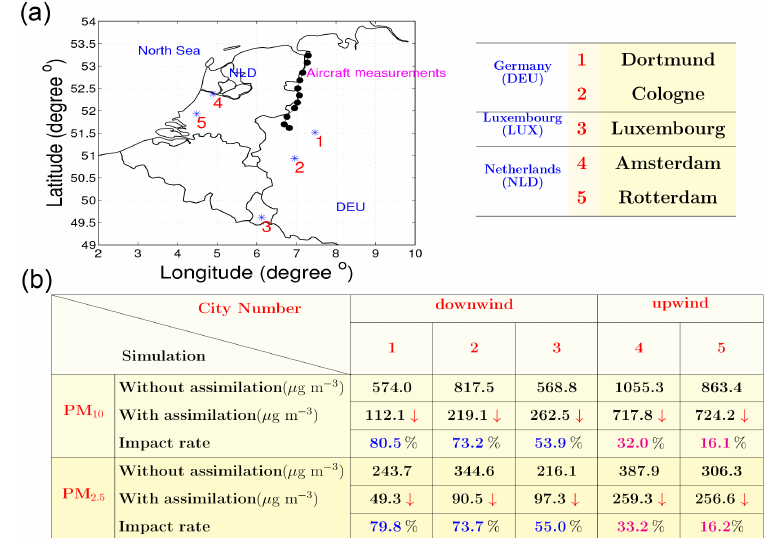
Figure 5. PM 10 and PM 2 . 5 evaluation on selected cities with and without assimilation. (a) Selected international cities around the aircraft measurement track. City 1–3 are in the downwind direction, while city 4–5 are in the upwind direction. (b) Concentrations of PM 10 and PM 2 . 5 and the quantified impact rates on selected cities. The height of interest is chosen at 3km. The red arrow represents the trend of concentration values due to the assimilation process. The impact rates in downwind and upwind cases are distinguished by blue and magenta